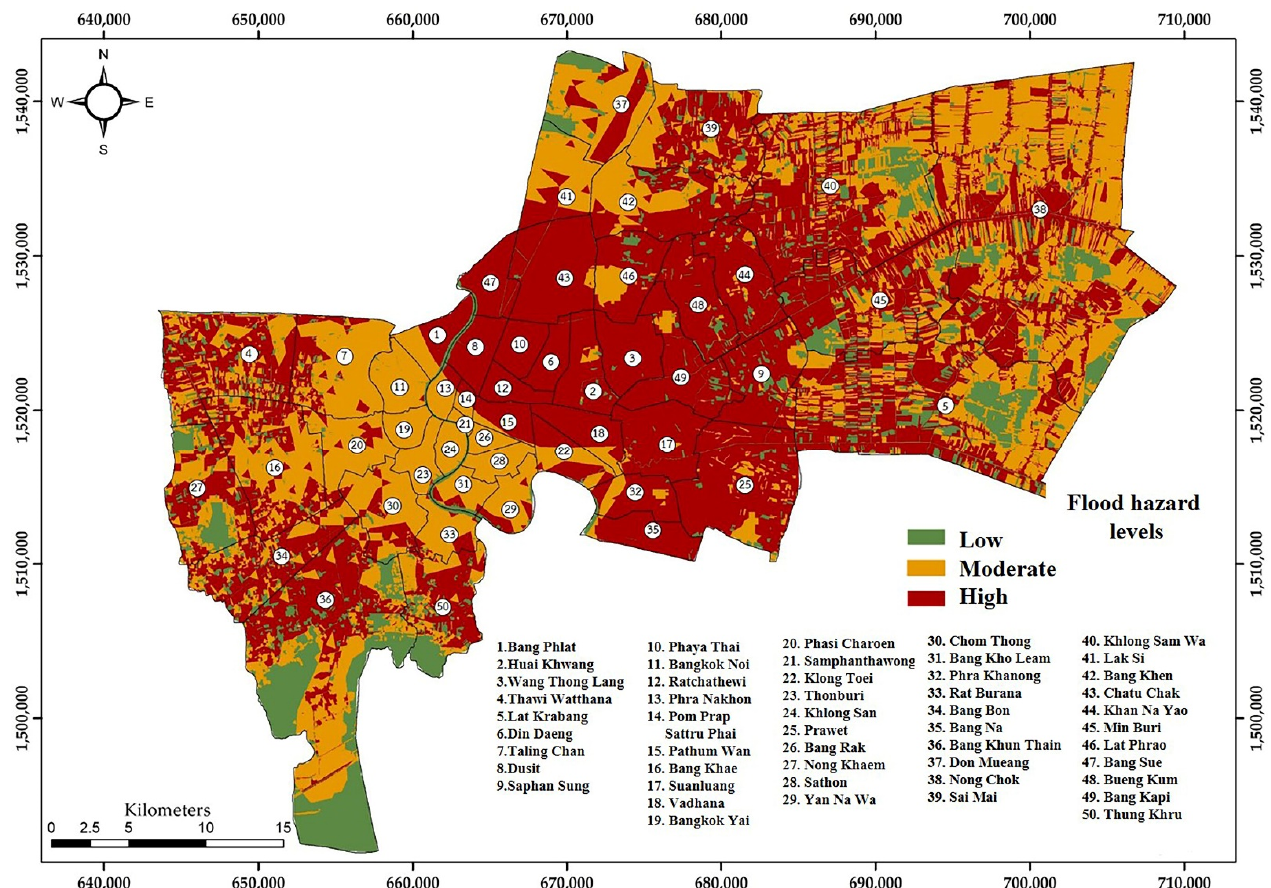
Figure 3. Bangkok’s flood hazard map based on GIS-AHP Multicriteria Analysis.